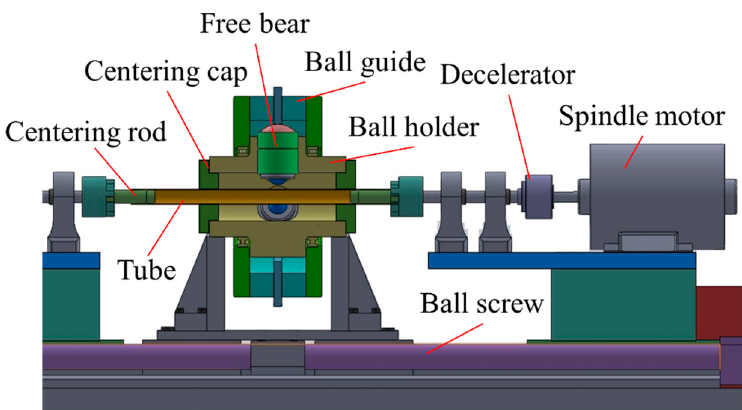
Figure 11. Schematic diagram of the experimental machine.